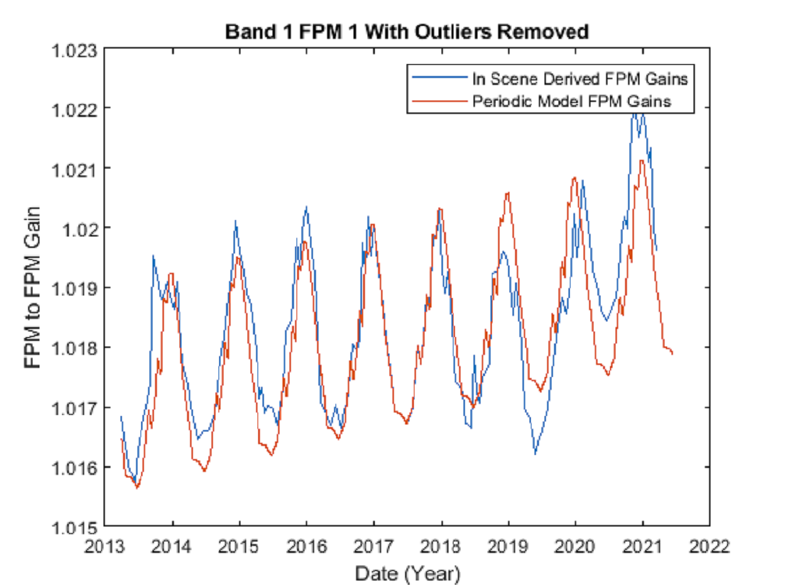
Figure 10. In-scene derived FPM gains for Band 1 FPM 1 from Arabian Desert scenes (blue) compared with periodic model FPM gains (red) graphed across Landsat 8’s lifetime. Each of the 14 FPMs have a model similar to this and some are positively linear while others are negatively